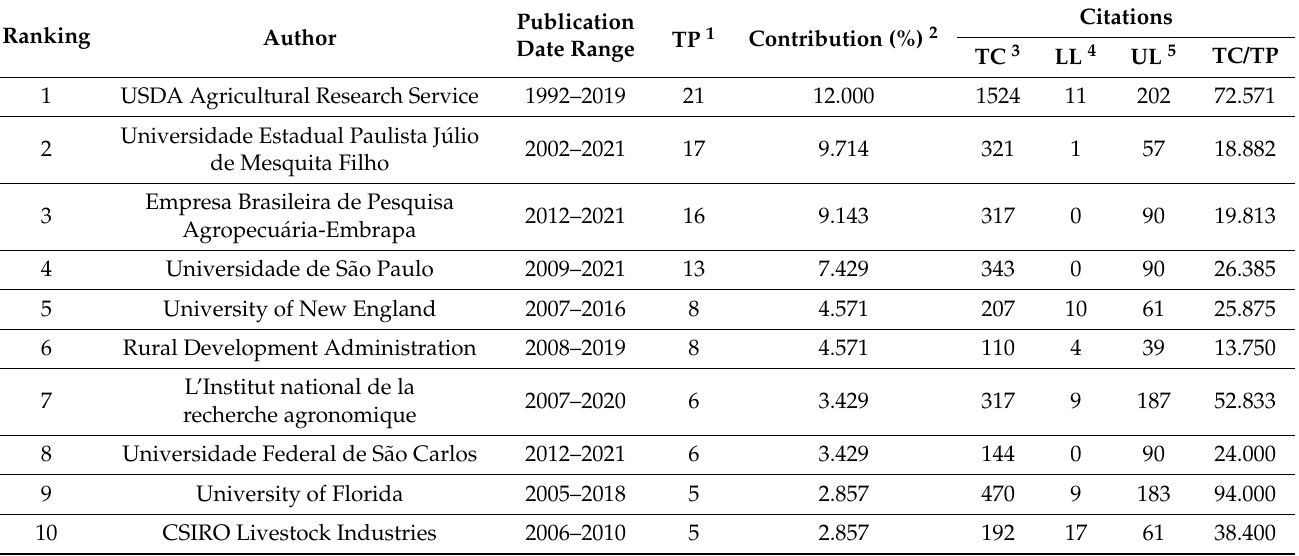
Table 3. Institutions with more participation in research on the role of causal genes in meat